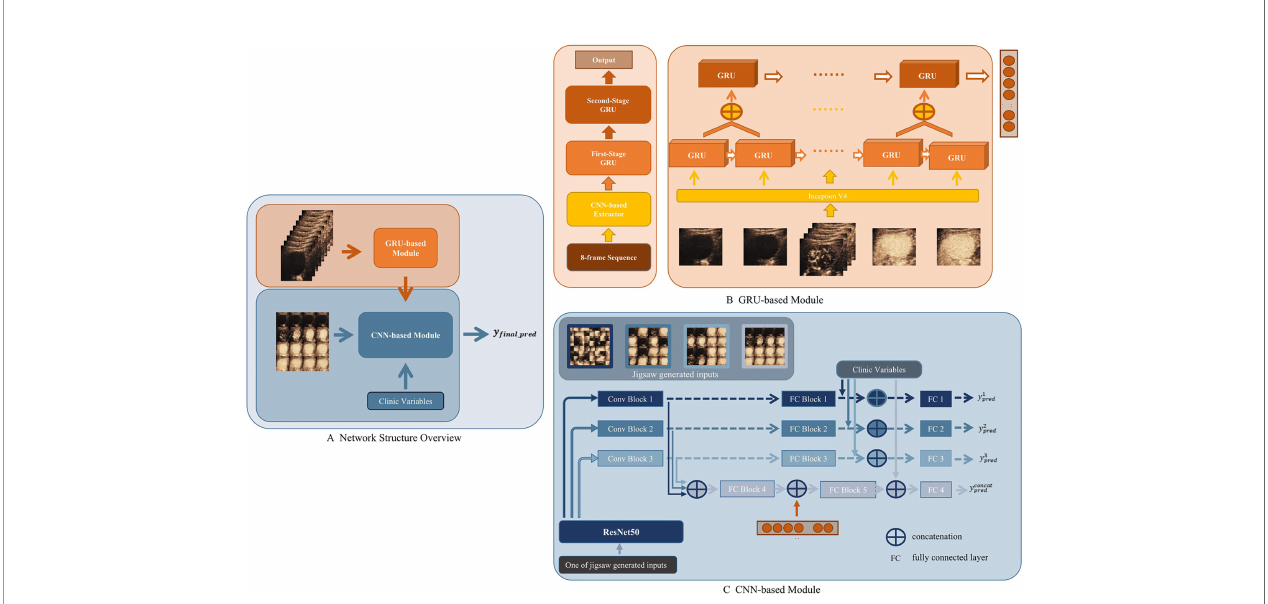
FIGURE 2 | Work fl ow of deep convolution neural network (DCNN) analysis. (A) Network Structure Overview. Eight-frame sequence was the input of the Gated Recurrent Unit (GRU)-based module. Sixteen-frame spliced image, output of the GRU-based module, and the clinic variables were the inputs of the convolution neural network (CNN)-based module. (B) GRU-based module. The feature extracted by the CNN-based Extractor was fed into a two-stage cascade GRU to get a one-dimension output. (C) CNN-based module. In the training stage, a jigsaw puzzle generator was applied to randomly generate three different patch sizes of image inputs based on the 16-frame spliced image. Three generated image inputs and the original image were then fed into pipelines composed by Conv Blocks and fully connected (FC) Blocks,